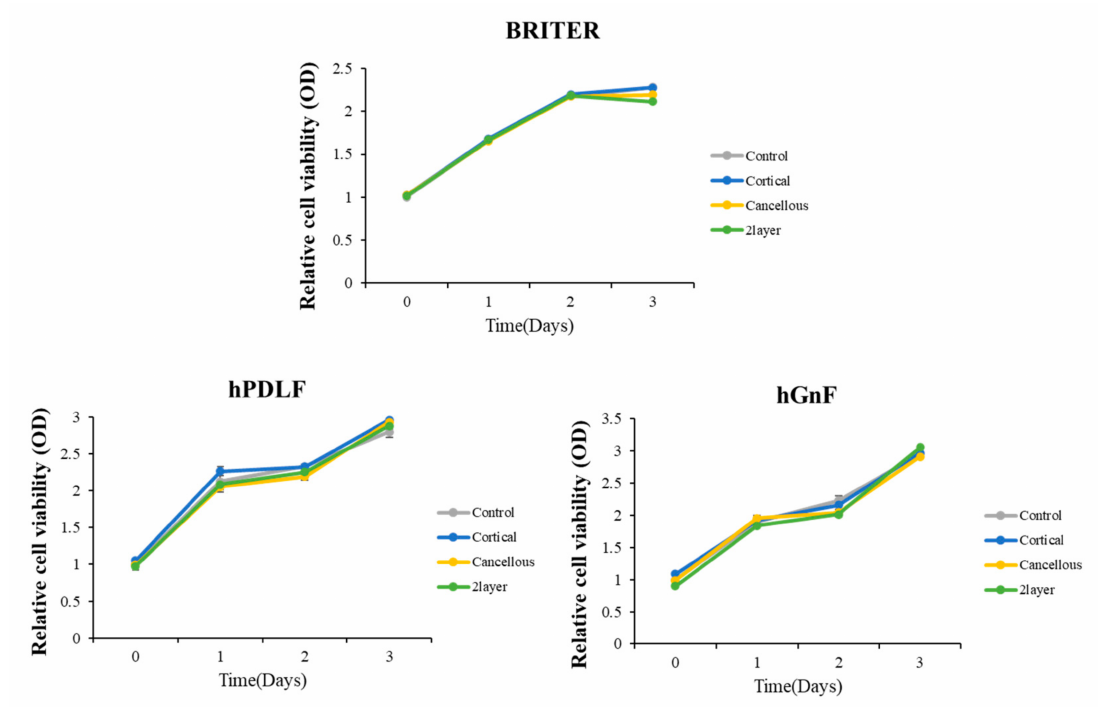
Figure 4. Cell viabilities of each group on mouse BMP responsive reporter osteoblast cell line (BRITER), human periodontal ligament fibroblasts (hPDLF), and human gingival fibroblasts (hGnF) cells ( p >